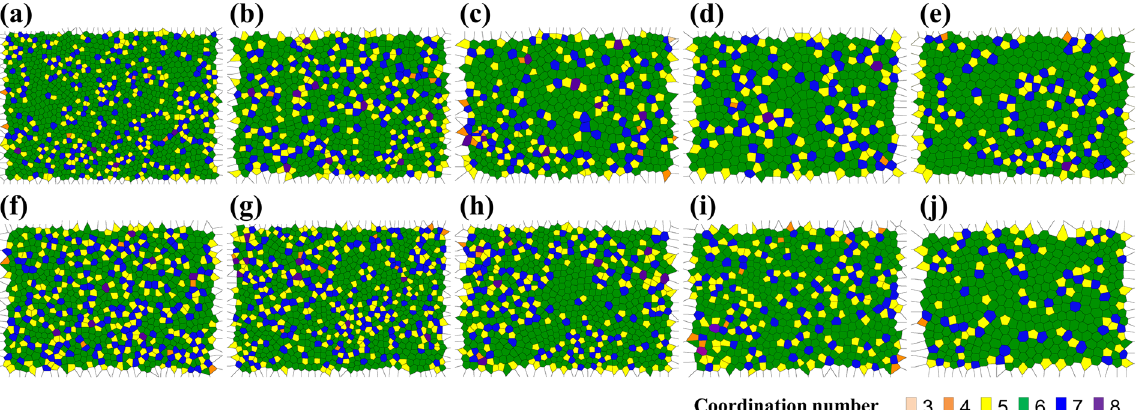
Figure 2. Voronoi diagrams of TiO 2 nanotube arrays anodized at 60 V for 1 hour in ethylene glycol containing (a–e) 2, 4, 6, 8, 10 vol% distilled water with 0.2 wt% NH 4 F and (f–j) 2, 4, 6, 8, 10 vol% distilled water with 0.4 wt% NH 4 F. Coordination numbers of cells are expressed in colors: rachel: 3, orange: 4, yellow: 5, green: 6, blue: 7, violet: